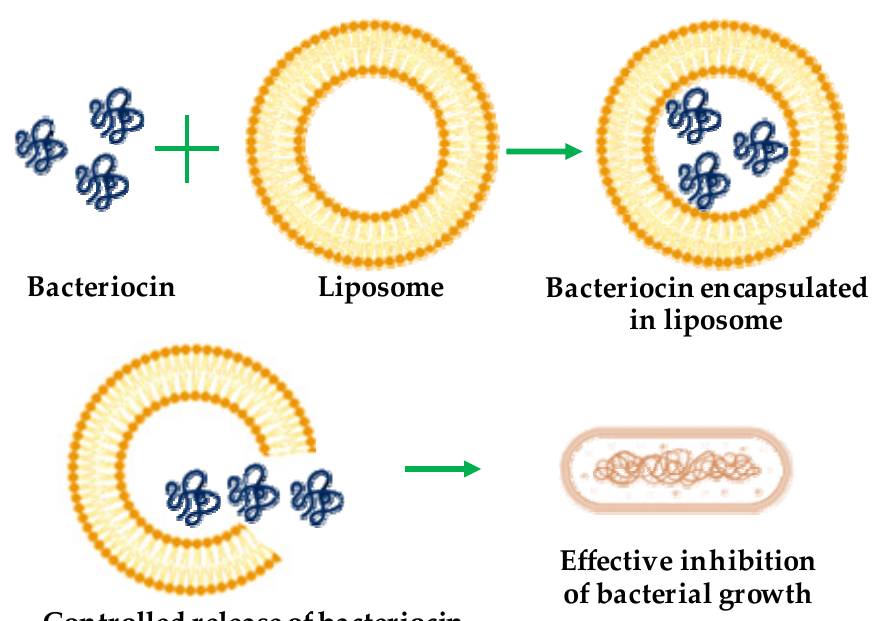
Figure 2. Schematic representation of bacteriocin encapsulation with liposome for antibacterial activity.